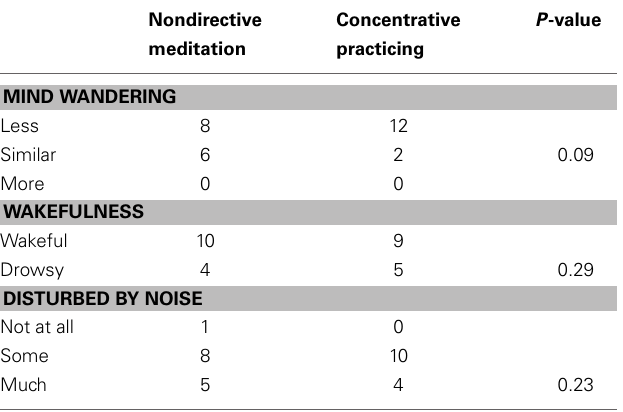
Table 1 | Meditation experience during scanning assessed by post-scan questionnaire.